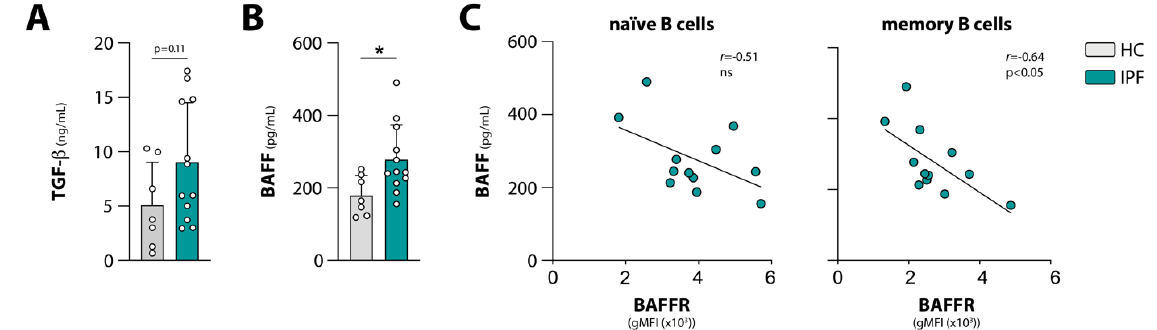
Figure 3. Analysis of circulating BAFF and TGF- β levels in HC and IPF patients (subset of cohort 1). ( A ) TGF- β levels in plasma of HCs and IPF patients measured by ELISA. ( B ) BAFF levels in plasma of HCs and IPF patients measured by ELISA. ( C ) Pearson correlation analysis between BAFF levels in plasma and BAFFR surface expression on naïve (CD3 − CD19 + CD38 lo CD27 − IgD + ) and memory (CD3 − CD19 + CD38 lo CD27 + ) B cells in IPF patients. Subjects are indicated by individual data points, and bars indicate mean values + SD. * p < 0.05 in ( B ) by an unpaired two-tailed Student’s t